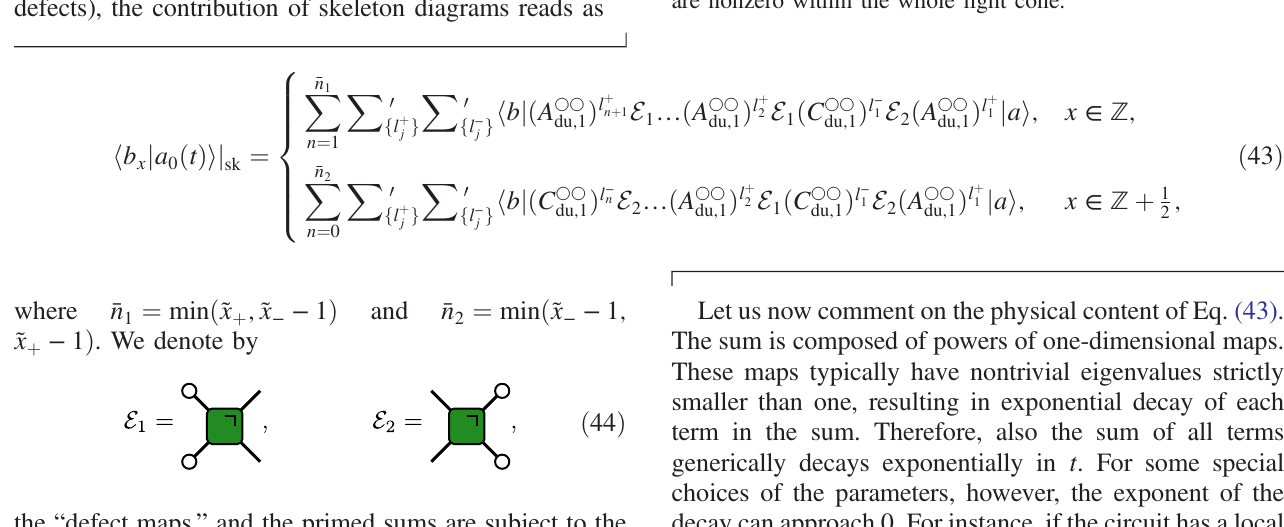
FIG. 2. Correlations between integer sites in a perturbed dual- unitary circuit with density of defects δ ¼ 1 , where the gate is defined in Table I (gate 2). We see a reminiscence of the dual- unitary behavior with a strong peak along the light-cone edge. As opposed to the pure dual-unitary result, however, the correlations are nonzero within the whole light